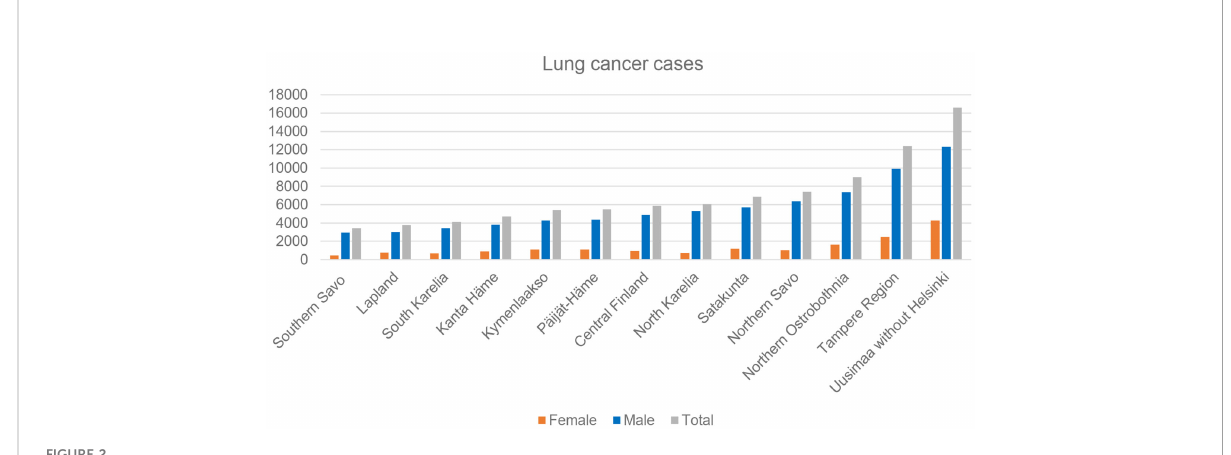
FIGURE 2 Diagnosed lung cancer cases by hospital district in Finland from 1955 to